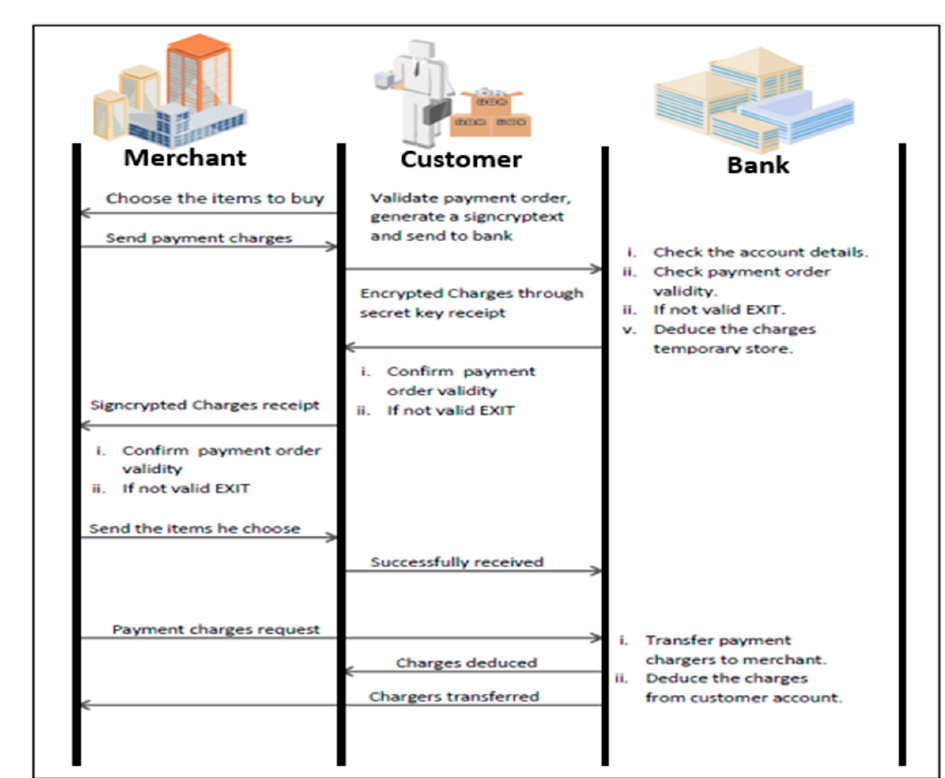
Figure 3. Explanation of application.